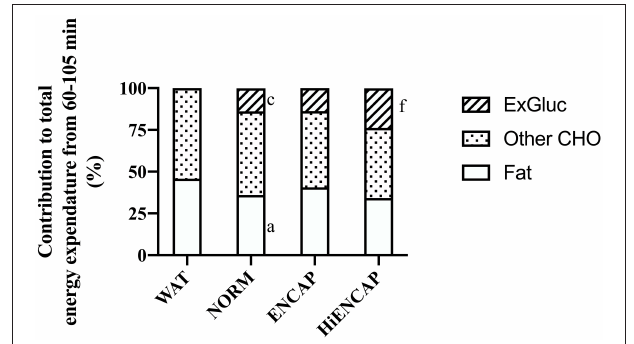
FIGURE 3 | Relative contribution to energy expenditure from 60–105min. a = significant difference between NORM and WAT, c = significant difference between NORM and HiENCAP, and f = significant difference between ENCAP and HiENCAP. n = 8. Values are